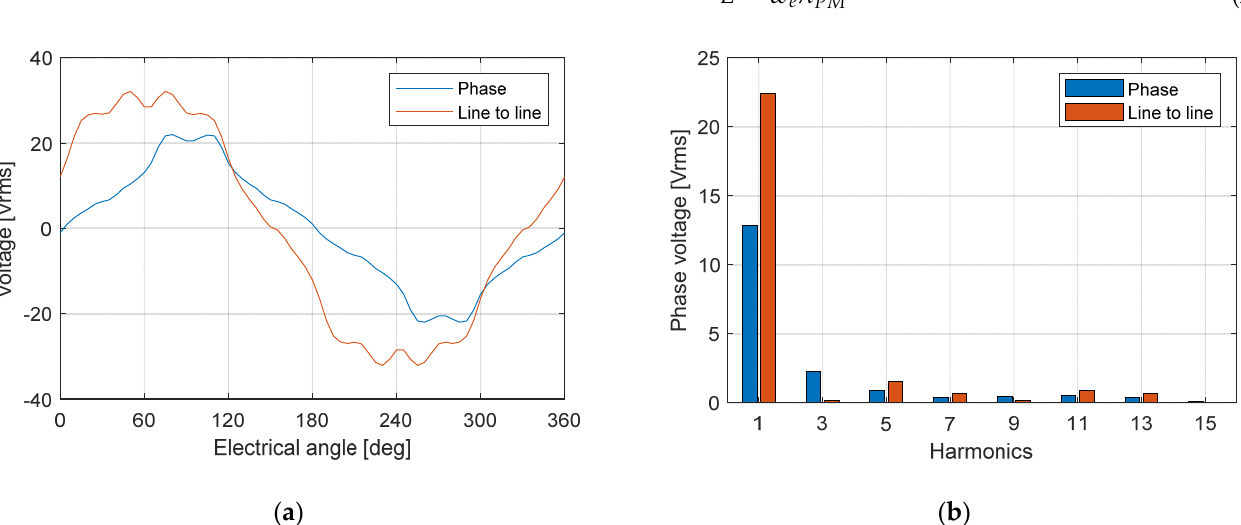
Table 4. BEMF values by harmonics.